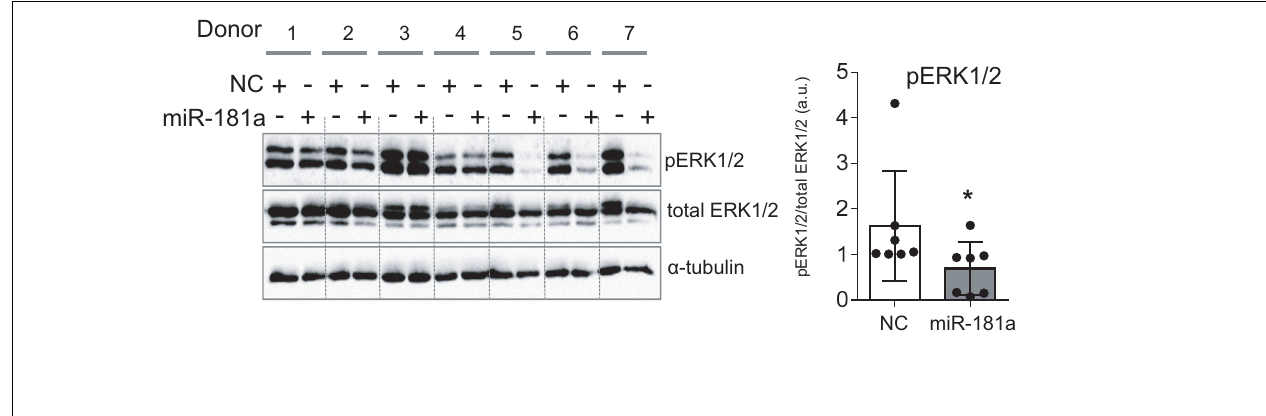
FIGURE 5 | MiR-181a inhibited ERK1/2 phosphorylation in MSC chondrogenesis. MSC ( N = 7) were transfected with miR-181a (gray), or with a control non-targeting miR (NC, white) mimic at day 0, and subjected to chondrogenic differentiation for 28 days. Accumulation of the indicated proteins was assessed by Western blot analysis at day 28 and a semi-quantitative evaluation of WB images for pERK1/2 was done in relation to total ERK1/2; α -tubulin was used as a loading control; error bars represent mean values ± SD; *p ≤ 0.05 (Mann–Whitney U ).